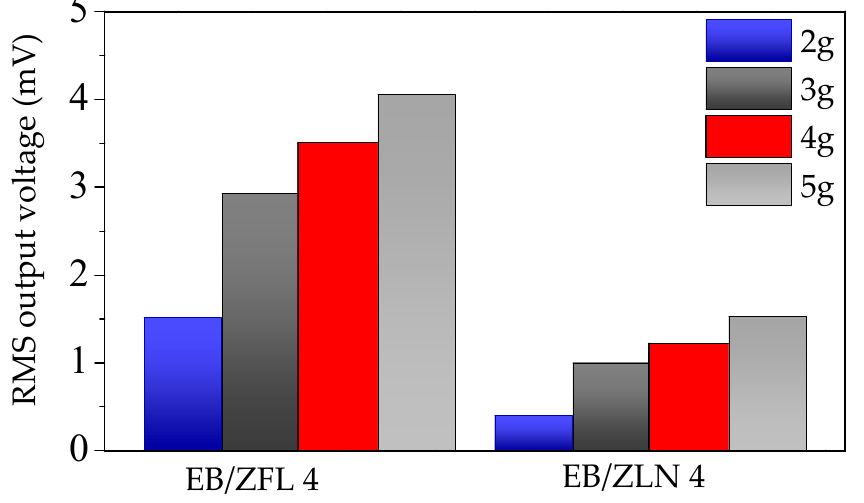
Figure 13. RMS output voltage values produced by composites containing 4 wt.% of ZnO (flower-like (ZFL) and needle (ZLN) structures) at the frequency of 19 Hz and different acceleration values (namely, 2, 3, 4, and 5 g).